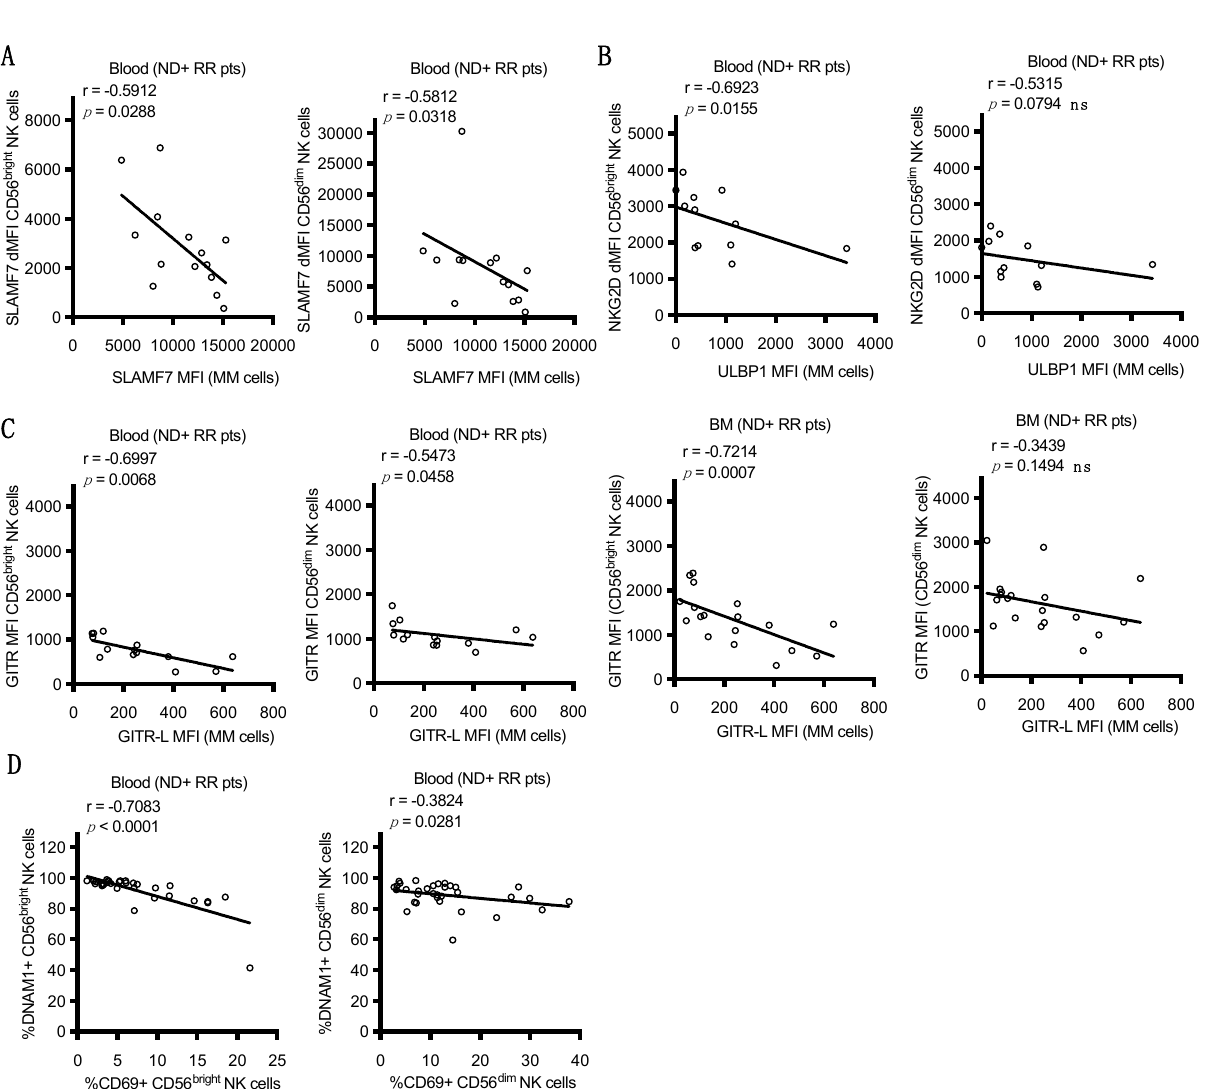
Figure 3. Correlations of NK cell receptor expression with ligand expression on MM cells in BM from pooled ND and RR (ND+RR) patients. Each symbol is an individual patient. Statistics were calculated with Spearman’s rank correlation coefficient, lines are linear least squares fit for visual purposes only. Patients with corresponding blood and BM samples from ND+RR patients were examined for correlations between expression levels of the indicated receptors (y-axes) in blood or BM (as indicated) and expression of their corresponding ligands on myeloma cells in the BM (x-axes). ( A ) Correlations between dMFI of SLAMF7 expression on blood CD56 bright (left) and CD56 dim NK cells (right) and on myeloma (MM) cells in BM. ( B ) Comparisons of dMFI of NKG2D expression on blood CD56 bright (left) and CD56 dim NK cells (right) and the NKG2D ligand, ULBP1, on MM cells in BM. ( C ) Correlations between MFI expression levels of GITR on NK cell populations in blood (left panels) or in BM (right panels) with expression of GITR-L on MM cells in the BM. ( D ) Correlation between % CD56 bright (left) or CD56 dim (right) NK cells in blood that are DNAM-1 + and their % expressing the CD69 activation marker.